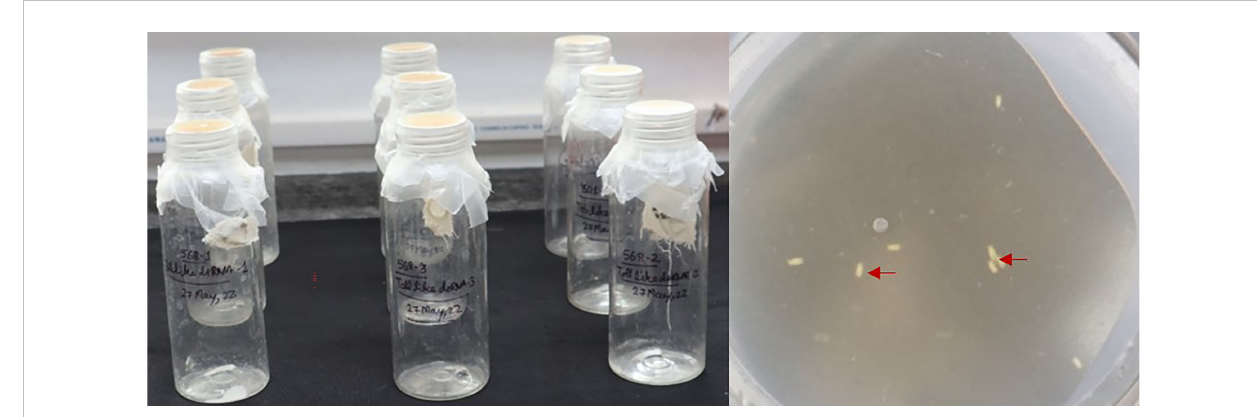
control at 48 hr. The downregulation of target gene expression was consistent in all the biological replicates. Similarly, TOB1 dsRNA signi fi cantly down-regulated the TOB1 mRNA level by 3.01-fold (Figure 2). The log2 − DD CT value of B. tabaci TOB1 expression was 3.19 under normal conditions. The reduction in the target mRNA expression level of B. tabaci was signi fi cantly higher in TLR3 dsRNA exposure than TOB1 dsRNA at 48 hr after oral delivery. The expression of B. tabaci TLR3 and TOB1 post TpCOL3A1 dsRNA exposure was statistically at par with untreated control. There was no signi fi cant regulation of the endogenous control gene, b -actin between dsRNA-exposed and non-exposed B. tabaci populations which indicated the speci fi city of the TLR3 and TOB1